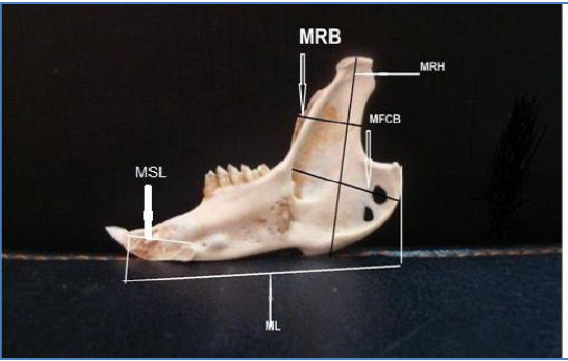
Figure, 2: the medial surface of the mandible of the local rabbit showing the measurements which reported in (Table, 1). Minimum ramus breadth (MRB): least breadth of the mandibular ramus. Mandibular symphaysis length (MSL). Mandibular foramen caudal border (MFCB): the distance between mandibular foramen and caudal border. Mandibular length (ML): distance of the anterior of the alveoli of incisor to the posterior border of the ramus. Ramus height (MRH): direct distance from the highest point on the mandibular condyle. to the gonion (gn).